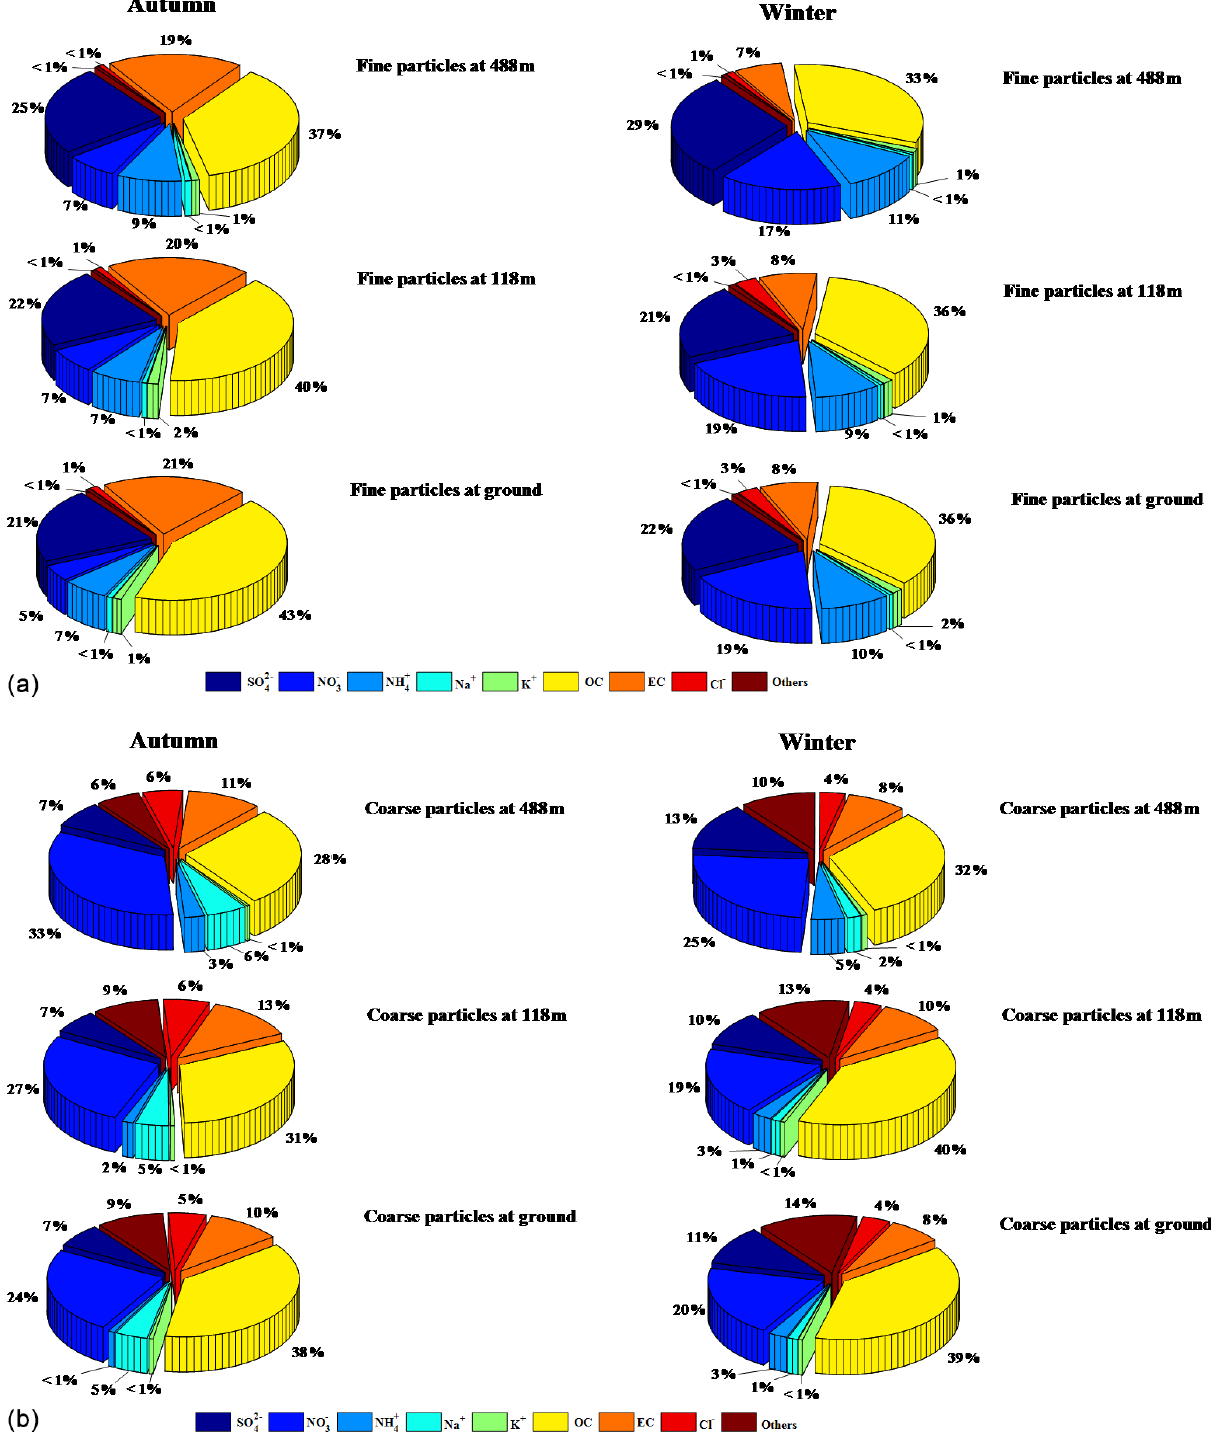
Figure 4. Relative importance of the main chemical components in (a) fine-mode and (b) coarse-mode particles at three different levels of the Canton